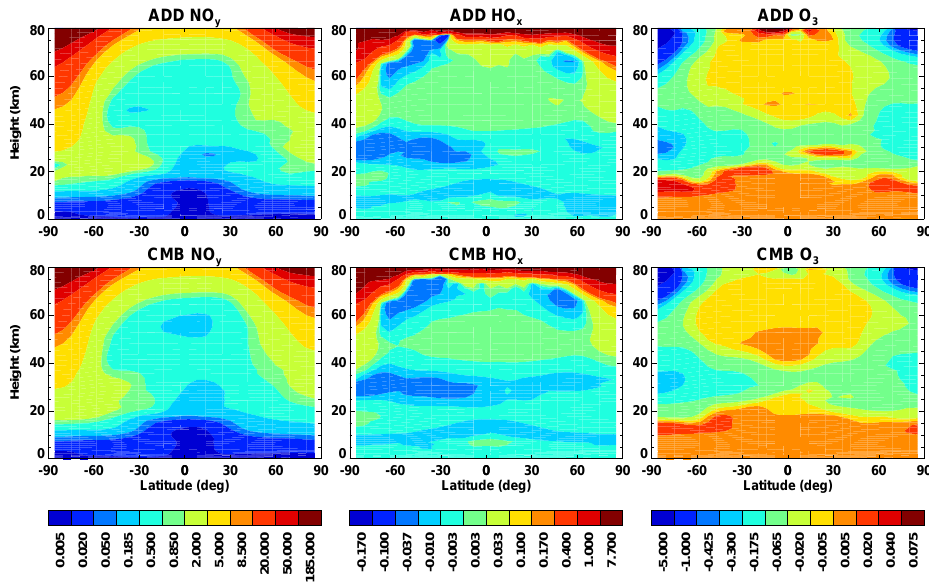
Fig. 8. Run mean, annual mean difference from the reference run for NO y (left, ppbv), HO x (middle, ppbv) and O 3 (right, ppmv). Top panels: sum for the individual auroral zone electrons, SPEs and GCR runs. Bottom panels: combined EPP run.